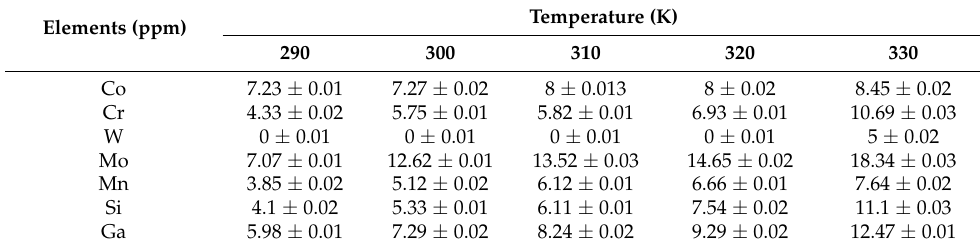
Table 5. Ions release for CoCr alloy at 290, 300, 310, 320 and 330